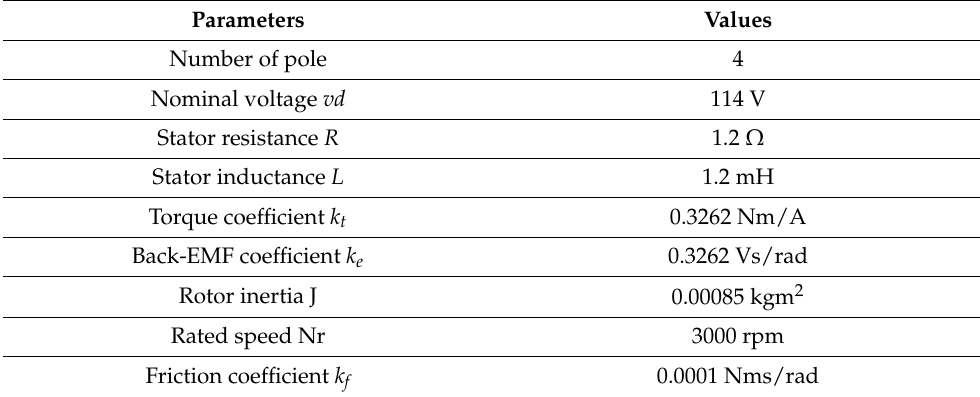
Figure 9. Scheme of PI controller parameters’ optimization based on a nature-inspired algorithm. The model of BLDC motor drive is simulated in MATLAB. The parameters of the BLDC motor are reported in Table 6. Table 6. Parameters of BLDC motor.